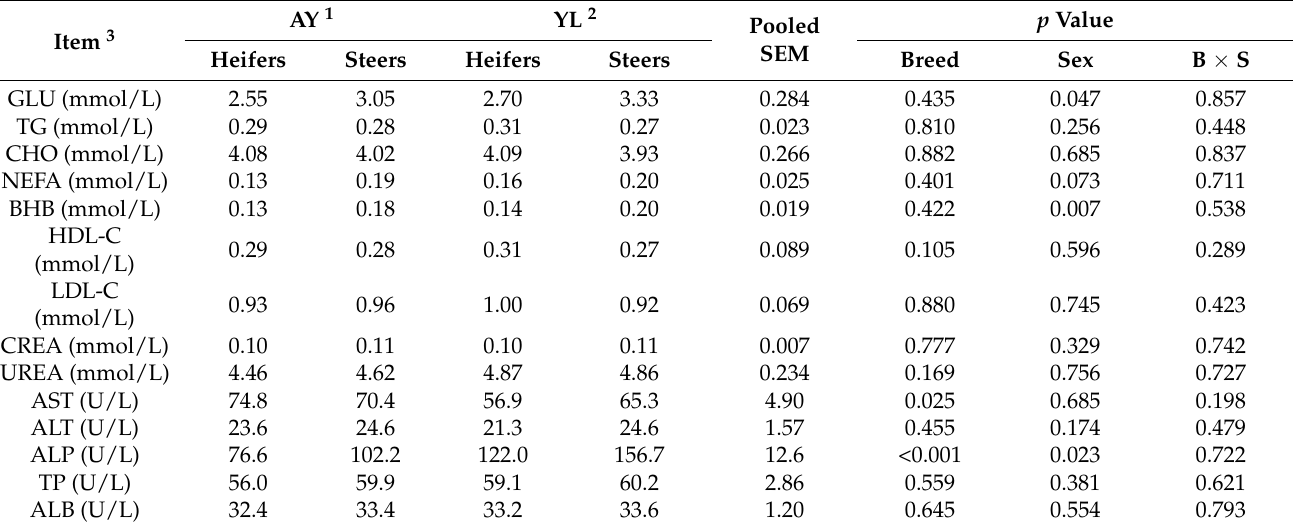
Table 2. The effects of breed and sex on serum biochemical parameters of